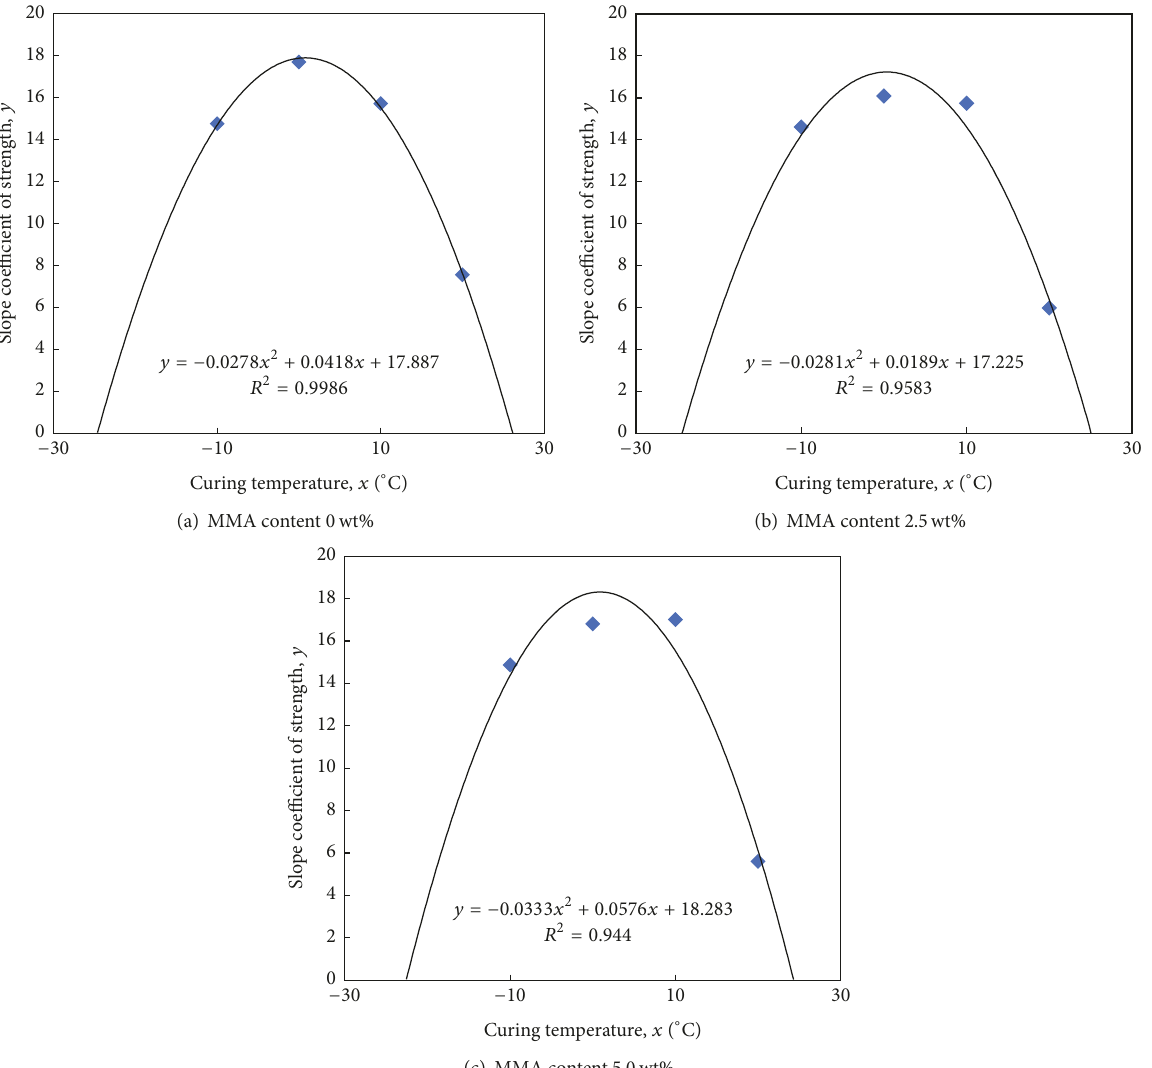
Figure 4: Curing temperature versus the slope coefficient of strength for computation of datum